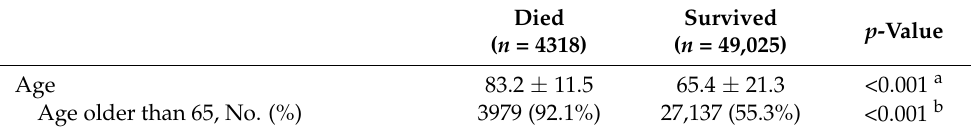
Table 8. Clinical characteristics of COVID-19 patients who died within 30